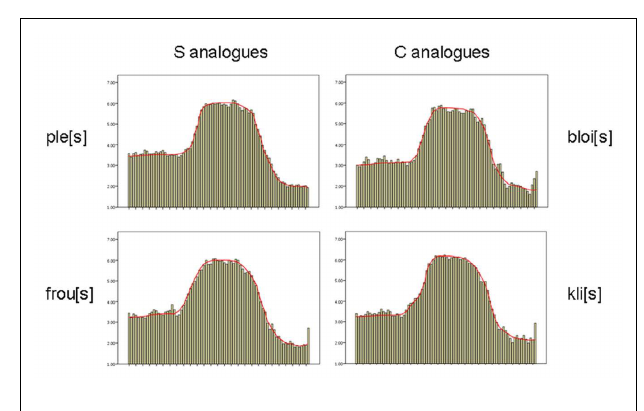
FIGURE 6 | Orthographically biased non-words rated by native English-speaking listeners: mean rated goodness as /s/, across the 81-step continuum from /z/ (left) through /s/ to / ∫ / (right), separately for each non-word with S-consistent real-word analogs (left column) or C-consistent real-word analogs (right